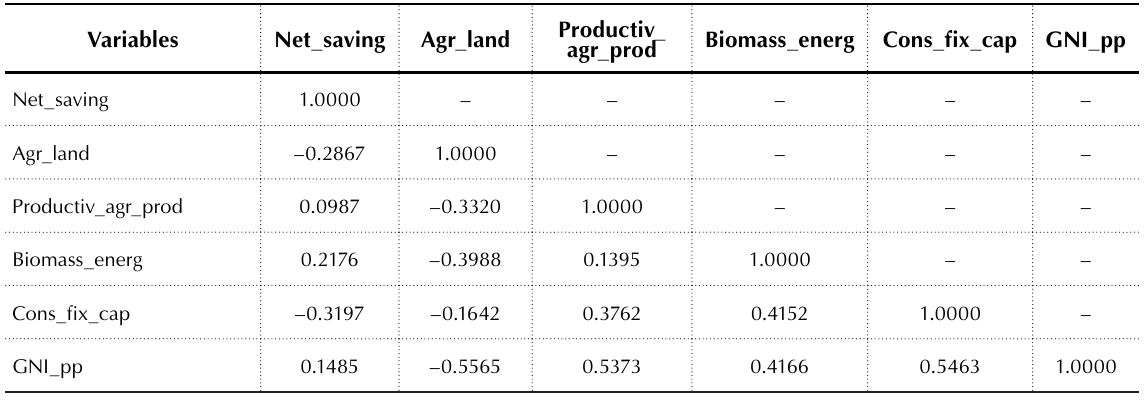
Table 5. Correlation matrix after the two variables exclusion